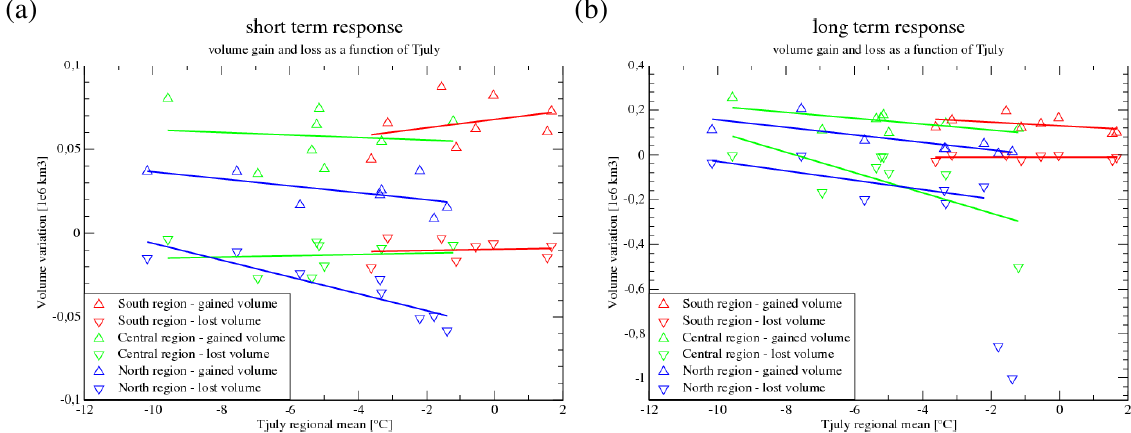
Fig. 10. Volume loss (down-pointing triangle) and gain (up-pointing triangle) as a function of July mean temperature. The tendency lines are also plotted (we omitted the two warmest models, ERA40 and REMO, for the tendency calculation of the North volume loss on the long-term response). The lost (resp. gained) volume is defined as the sum of the negative (resp. positive) thickness variation multiplied by the ISM grid cell area. On the left ( a ), the volume deviations after a 500-yr simulation and, on the right ( b ), after a 20-kyr simulation. Each pair of traingles (down and up-pointing) represent a particular atmospheric model.